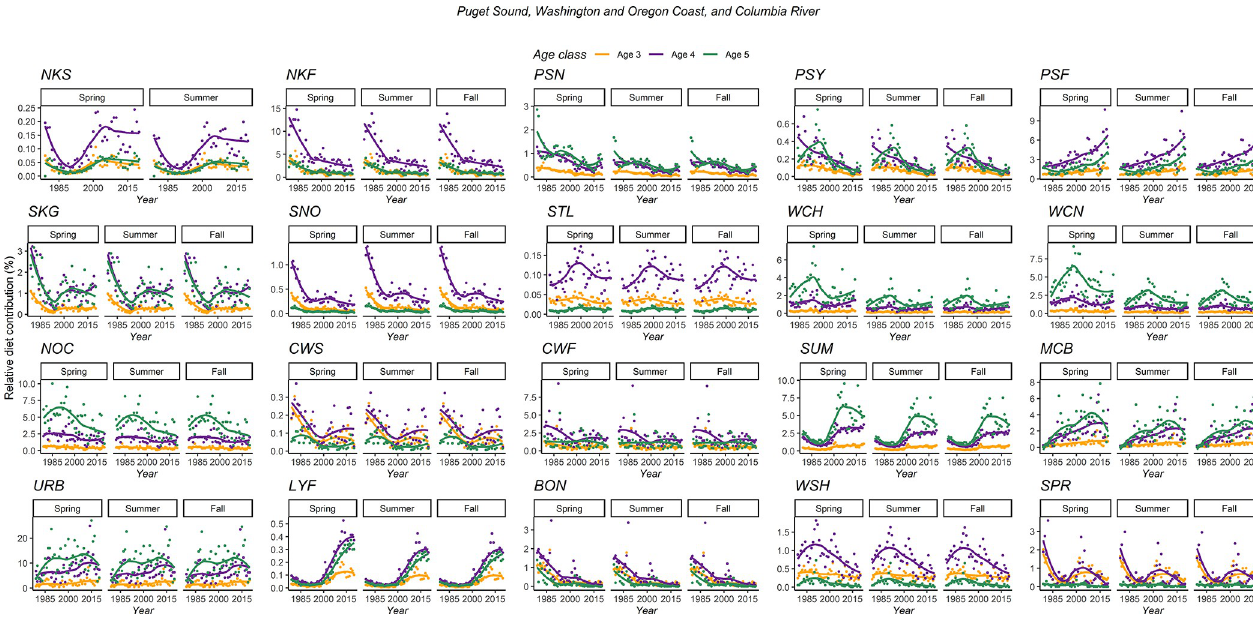
Fig 9. Estimated relative proportion of age-3, age-4, and age-5 Chinook salmon in the SRKW diet from 1979 to 2020. The stock codes refer to the PSC model, and all stocks are originating from Puget Sound, Oregon and Washington Coast, and the Columbia River.